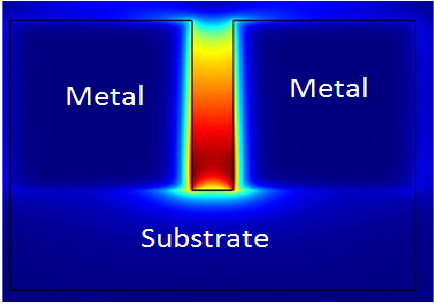
Fig.1. The field profile in a 50 nm slot mode waveguide with an air gap between two metal